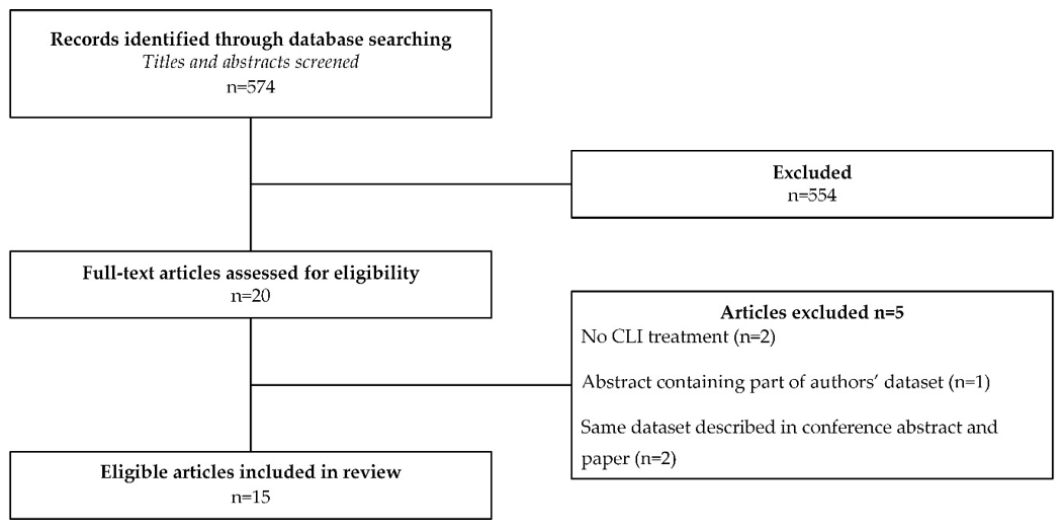
Figure 1. Flow chart: Selection of Studies.